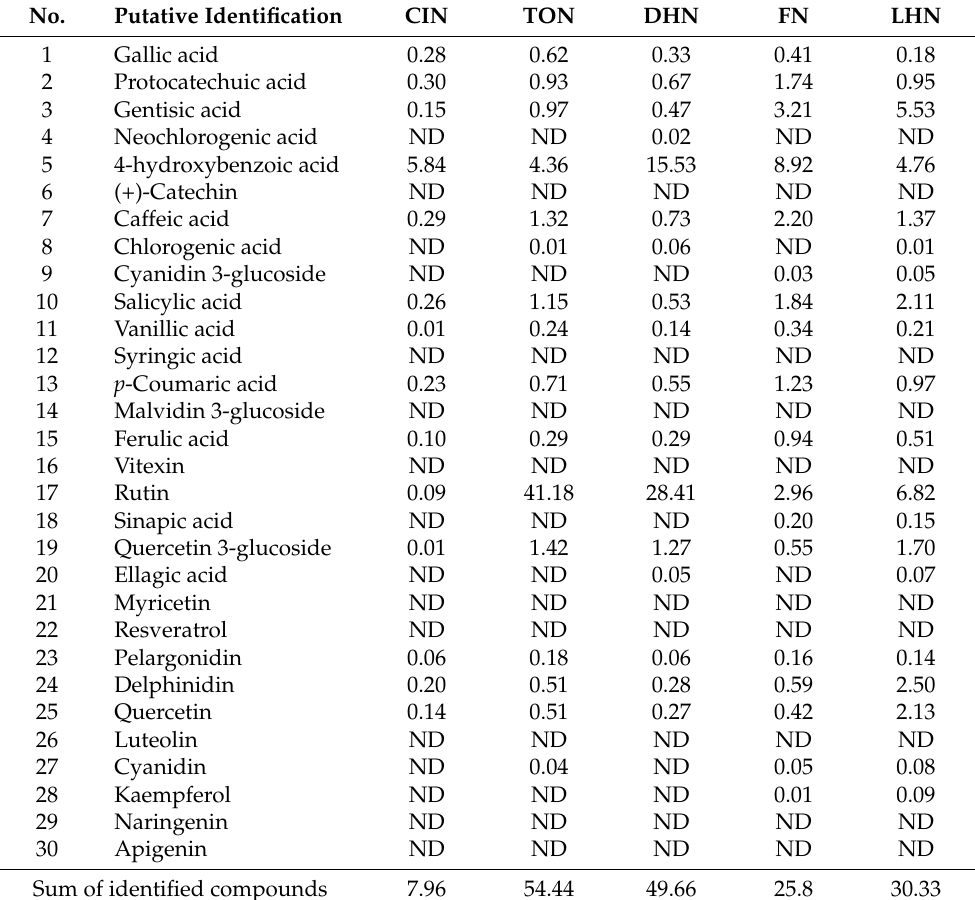
Table 6. Quantitative profiling of phenolic compounds in the noni juice samples using the developed LC-MS/MS method (values given as mg L-1 of the undiluted